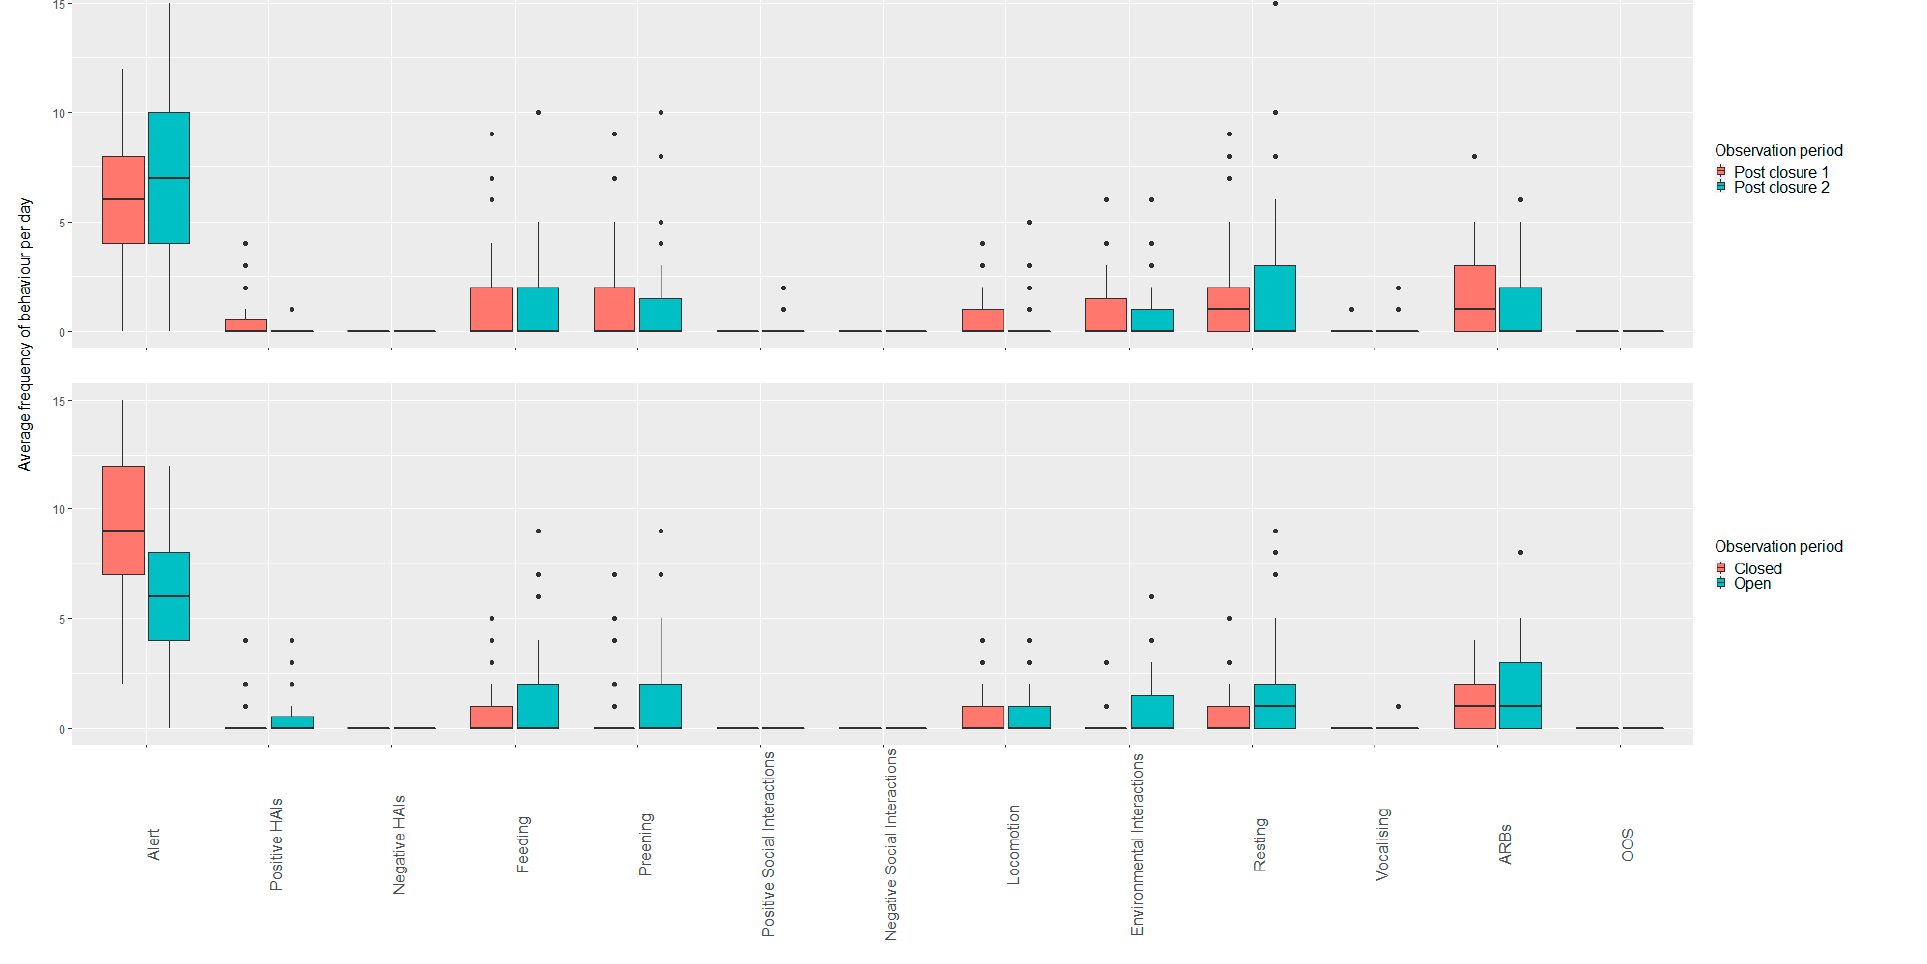
Figure 5. An overview of activity throughout the closure and reopening periods for the red and green macaw housed at Plantasia. Dots represent outliers.